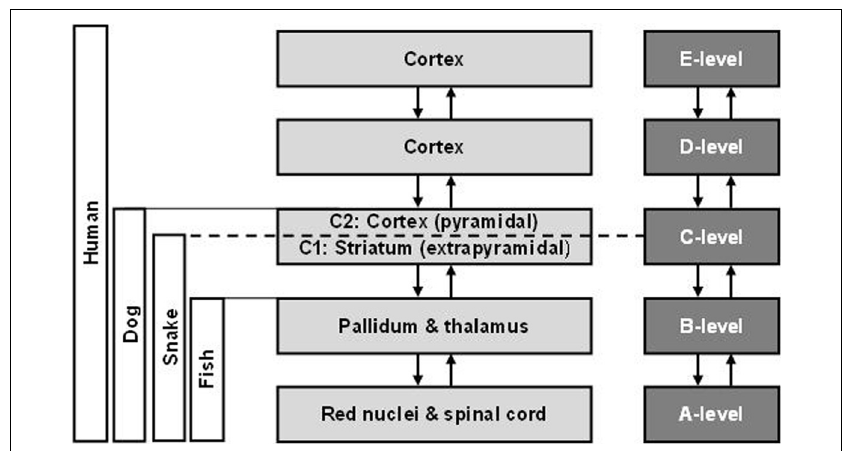
FIGURE 1 | The system of movements’ control levels according to N.A.